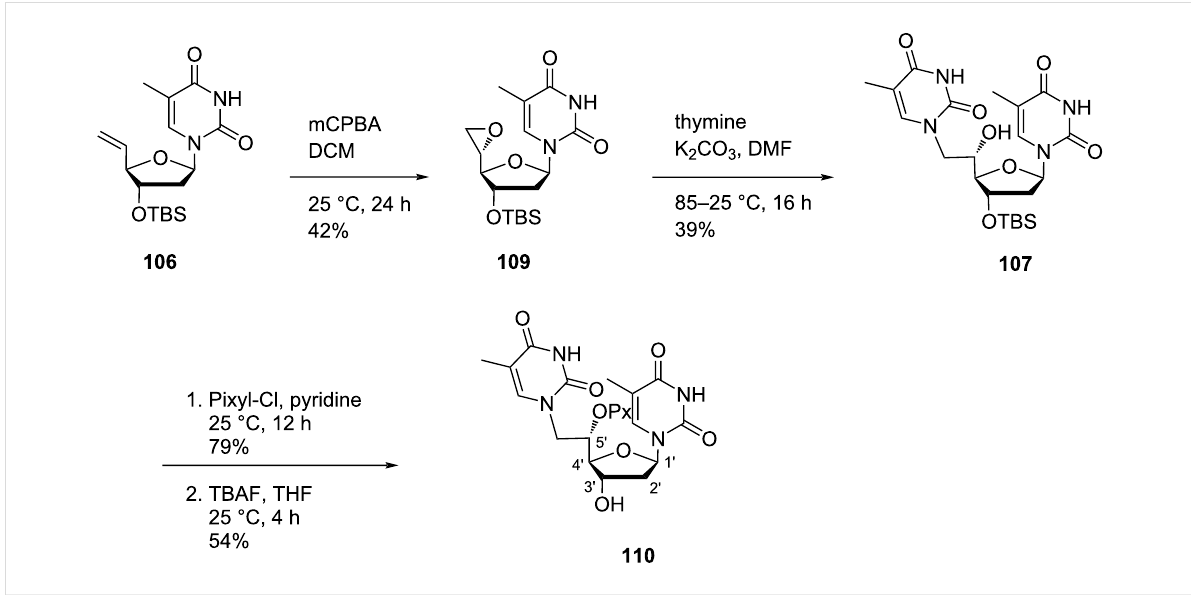
double-headed nucleosides in two complementary DNA